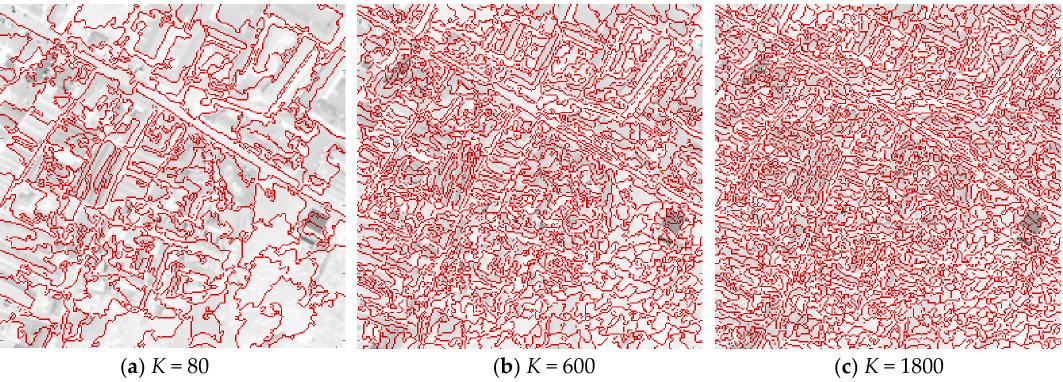
Figure 3. The result of superpixel segmentation with different number of superpixel.